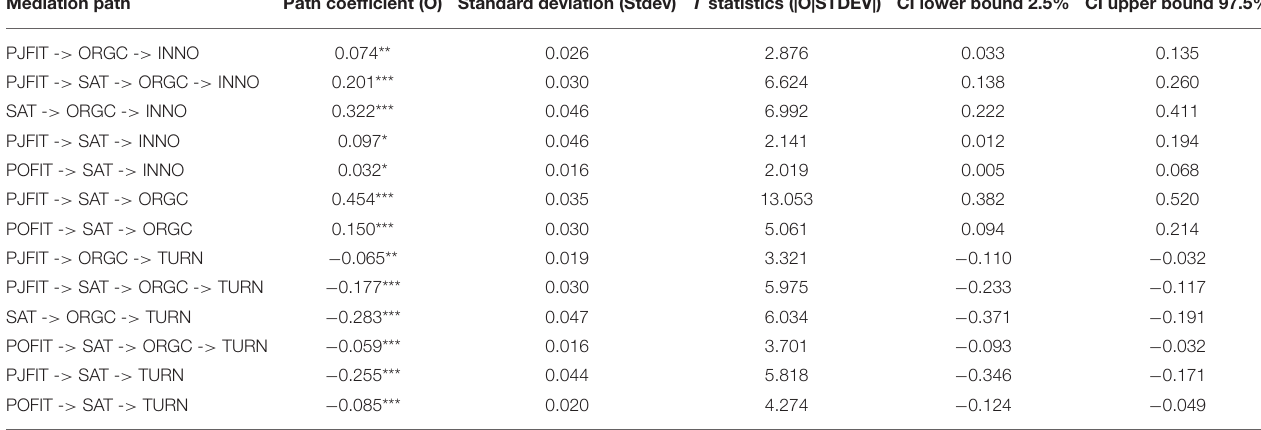
TABLE 6 | Mediation effect